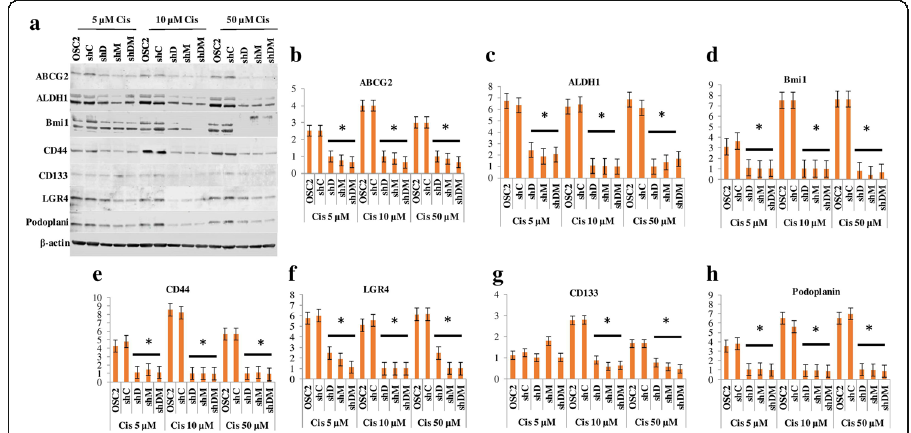
Fig. 3 WB analysis of OCSC makers following DSPP-MMP20 silencing and treatment with Cisplatin. a Total protein levels; b ABCG2; c ALDH1; d BMI1; e CD44; f LGR4; g CD133; h Podoplanin. Treatment with cisplatin was for 72 h at concentration of 5, 10, or 50 μΜ . Normalization of protein level was with β -actin. Y-(vertical) axis of histograms represent expression level for each protein relative to β -actin. OSC2=parent (untreated) cells; shC=control (scramble sequence) cells; shD=DSPP silenced cells; shM=MMP20 silenced cells; shDM=combined DSPP-MMP20 silenced cells. *p<0.05 compared with ShC. Experiments were performed in